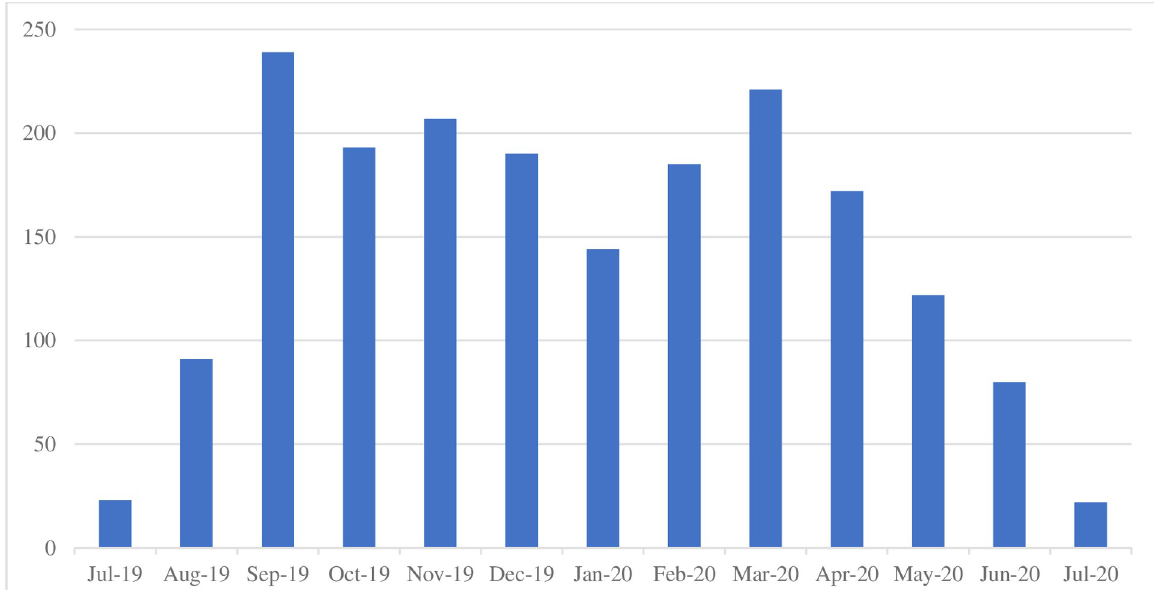
Fig 1. Distribution of Tweets per month (July 2019—July 2020).